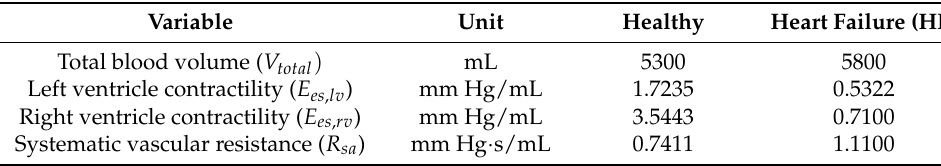
Table 3. CVS model parameters used to simulate HF